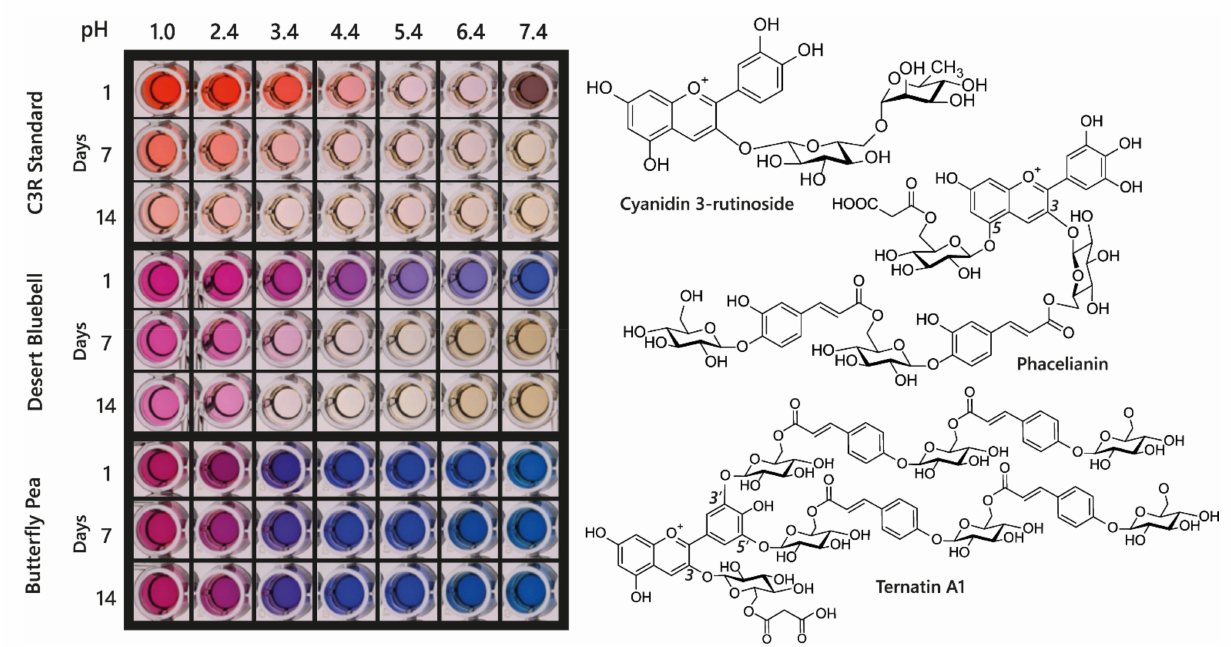
Figure 11. Demonstration of increasing blueness and increasing stability associated with multiple acylation of anthocyanins. Cyanidin 3- O -rutinoside was purchased commercially, and anthocyanins were extracted from desert bluebell ( Phacelia campanularia ) and butterfly pea ( Clitoria ternatea ). The most highly acylated anthocyanins in each extract are illustrated to the right. The plates show the colours of the anthocyanin extracts at different pH values and following storage at room temperature for 1, 7, and 14